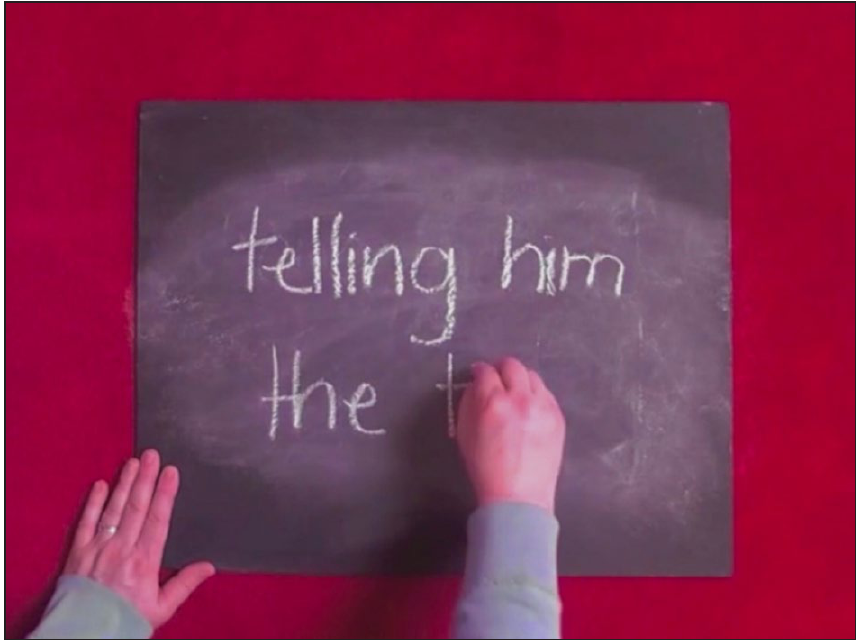
Figure 2: 50 things my son doesn’t need me for